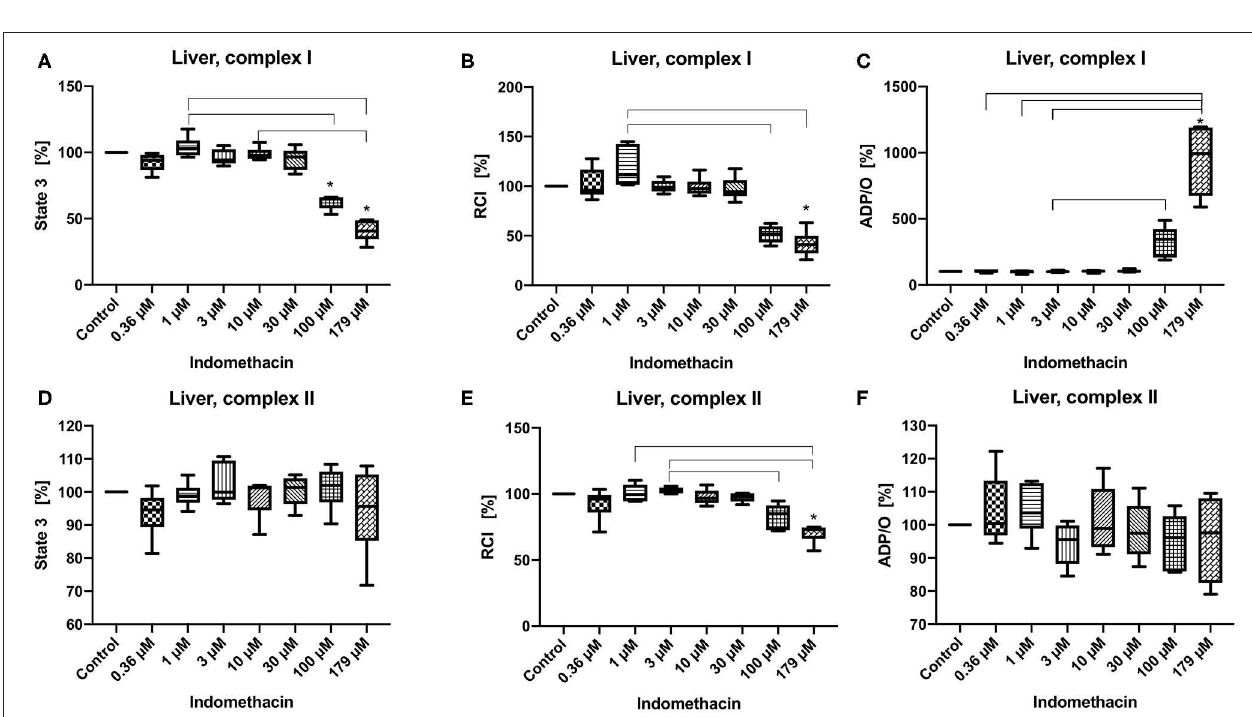
FIGURE 1 | Effect of indomethacin (0.36, 1, 30, 179, 300, 1,000, and 3,000 µ M) on colonic mitochondrial function: State 3 for complex I (A) and II (D) , respiratory control index (RCI) for complex I (B) und II (E) and ADP/O ratio for complex I (C) and II (F) . Data are shown as percentage of the control value (median/min/max), n = 6, * p < 0.05 vs. control, p < 0.05 between groups.